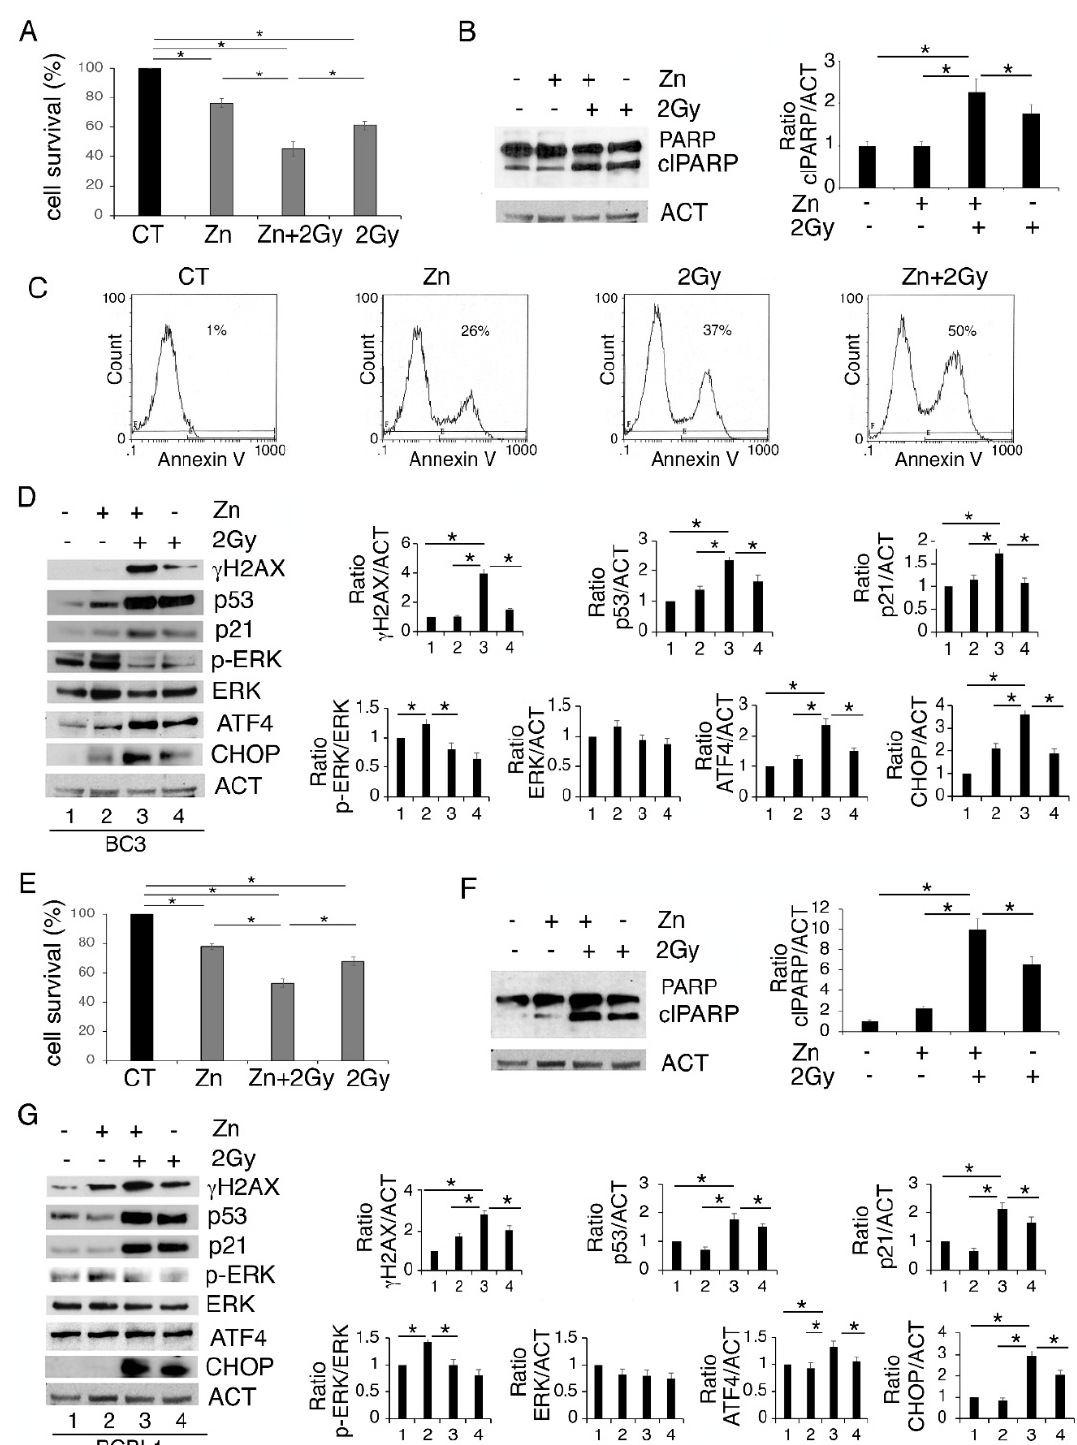
Figure 3. Zinc enhances DNA damage and p53 activation induced by radiation, reduces ERK1/2 phosphorylation, upregulating ATF4/CHOP axis and further impairing PEL cell survival. BC3 and BCBL1 were treated with Zinc and then exposed to 2 Gray (Gy) radiation. After 24 h of treatment cell survival was evaluated by trypan blue assay ( A , E ) and the expression level of PARP1 ( B , F ), γ H2AX, p53, p21, phospho- and total ERK1/2, ATF4 and CHOP were analyzed by Western blot ( D , G ). Densitometric analysis was performed as reported in Material Methods. Histograms represent the mean plus SD of three different experiments. ( C ) FACS profiles showing AnnexinV staining of BC3 cells undergoing the indicated treatments. * p -value < 0.05.